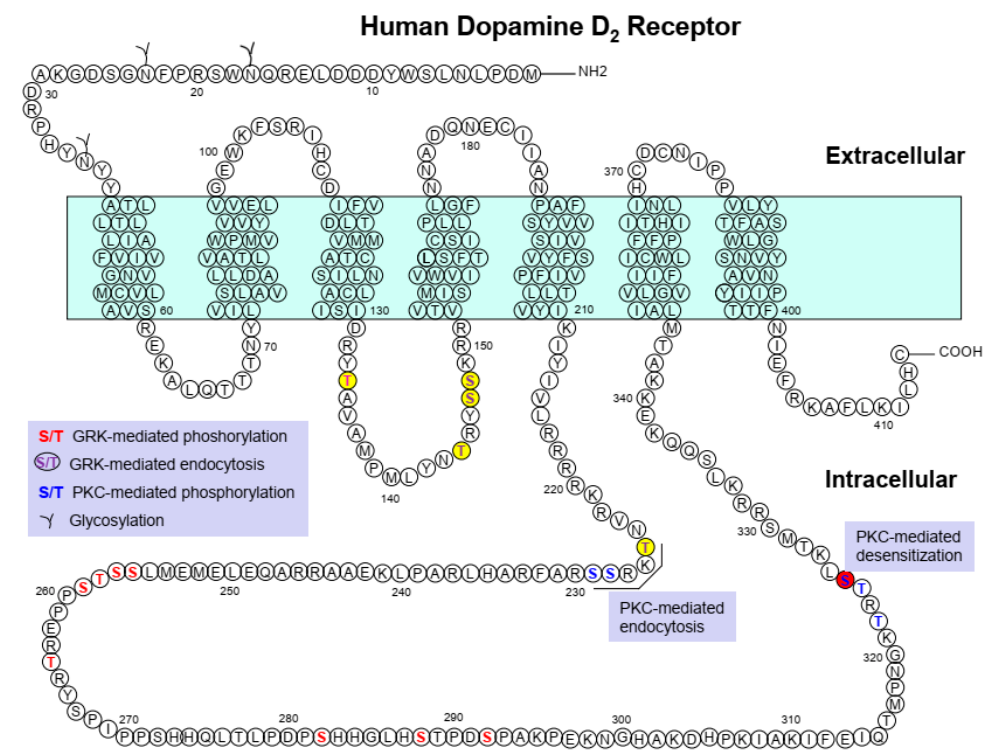
Figure 1. Major posttranslational modification sites of dopamine D 2 receptor and their functional roles. S/T residues highlighted in red indicate GRK-mediated phosphorylation sites; circles filled with yellow and S/T residues highlighted in purple indicate the amino acids responsible for GRK-mediated D 2 R endocytosis; S/T residues highlighted in blue indicate PKC-mediated phosphorylation sites.